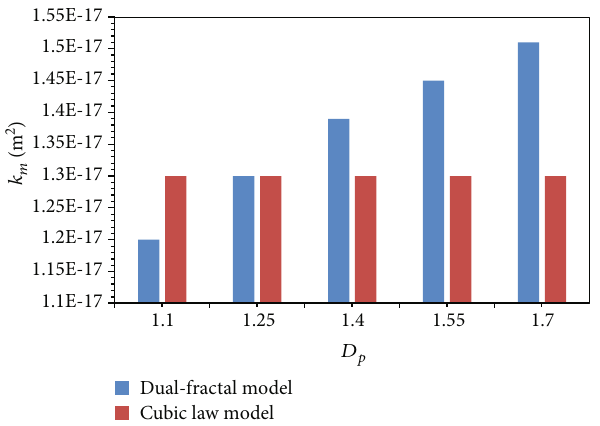
Figure 17: Permeability evolution under di ff erent fractal dimension of throat diameter.